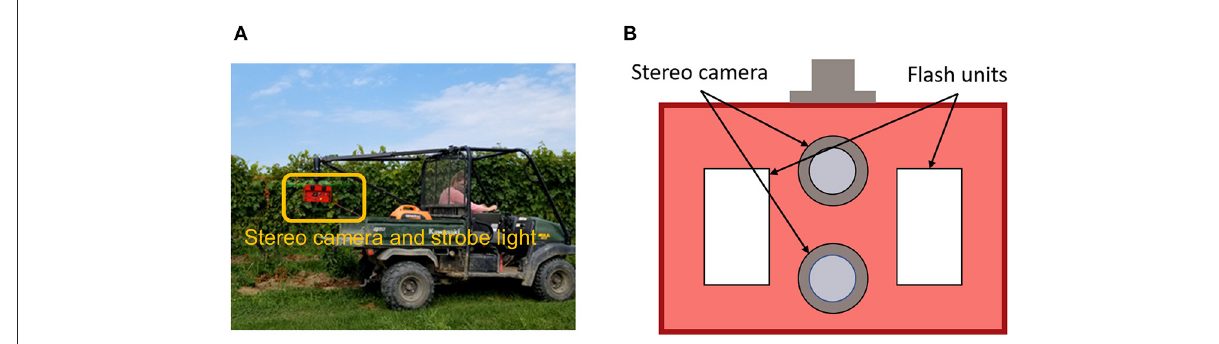
FIGURE1 Data collection system used in this study. (A) The imaging and illumination module highlighted in the orange box could be flexibly mounted on the ATV. (B) A reference detailed design of stereo camera and strobe light system (Silwal et al., 2021).